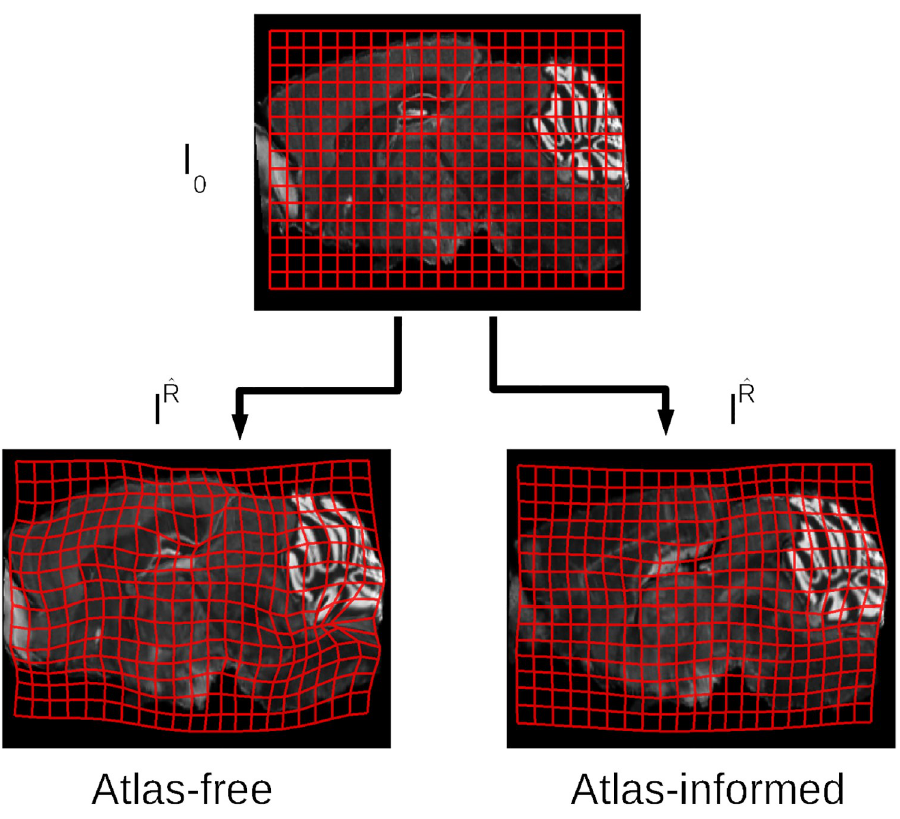
Fig 9. Comparison of diffeomorphic transformation recovered from atlas-free and atlas-informed models. The warped grids illustrate the difference in the mapping deformation from atlas (top) to target using the atlas-free method (bottom left) versus the atlas-informed method (bottom right), performed on real brain data from the MBA Project.